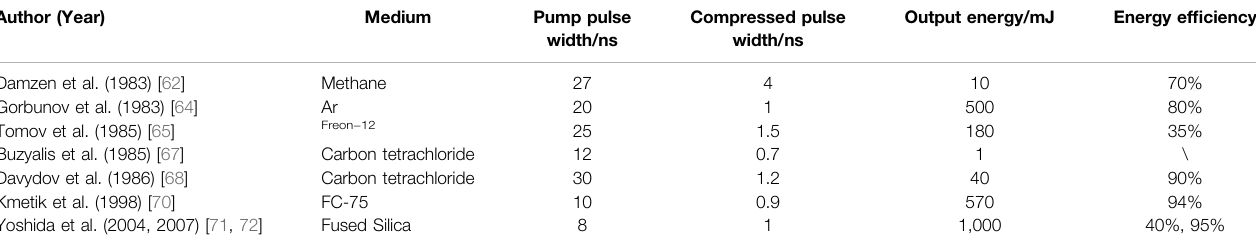
TABLE 1 | Typical experimental results in single cell structure.